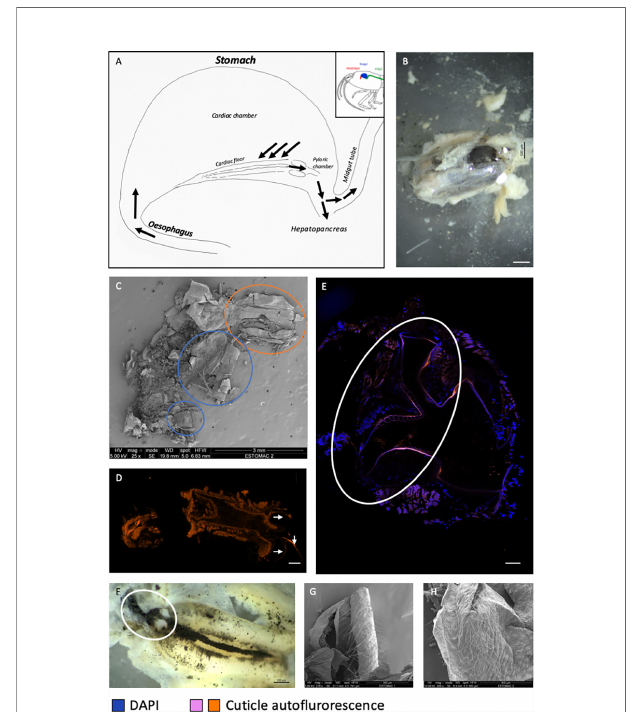
FIGURE 2 | General anatomy of the foregut of a R. exoculata adult. (A) Drawing of the general shape of a foregut of R. exoculata adult (see Figure 1F ). The black arrows indicate the path of the ingested materials through the stomach. (B) Stomach (black colored) dissected from the cephalothorax surrounded by hepatopancreas (white colored) of R. exoculata (binocular microscope, scale bar = 500 µm). (C) Opened critical-point dried foregut revealing its content (SEM, scale bar = 3 mm). The orange circle shows the œ sophagus and the blue circles show the cardiac fl oor sieve, which is broken in two parts. (D) Photography of the transversal section of an œ sophagus observed by auto fl uorescence in orange with 548 wavelength (image mosaic from 5734 x 11264 µm sections, scale bar = 20 µm). The white arrows show the ossicles where setae are located. (E) Transversal section of the pyloric chamber observed by auto fl uorescence in pink with 548 wavelength, image mosaic from 7577 x 7577 µm sections, blue DAPI staining showing host cell nucleus (image mosaic from DIC, Apotome ® , scale bar = 20 µm). The circle encloses the different plates and setae – view in transverse section- present in the pyloric chamber. (F) Cardiac fl oor sieve, with the different setae and minerals (binocular microscope, scale bar = 200 µm). The circle corresponds to the probable reduced pyloric chamber. (G, H) Inner part of the cardiac chamber showing thin and long setae (SEM). Scale bar = 300 µm (E) ; Scale bar = 400 µm (F)